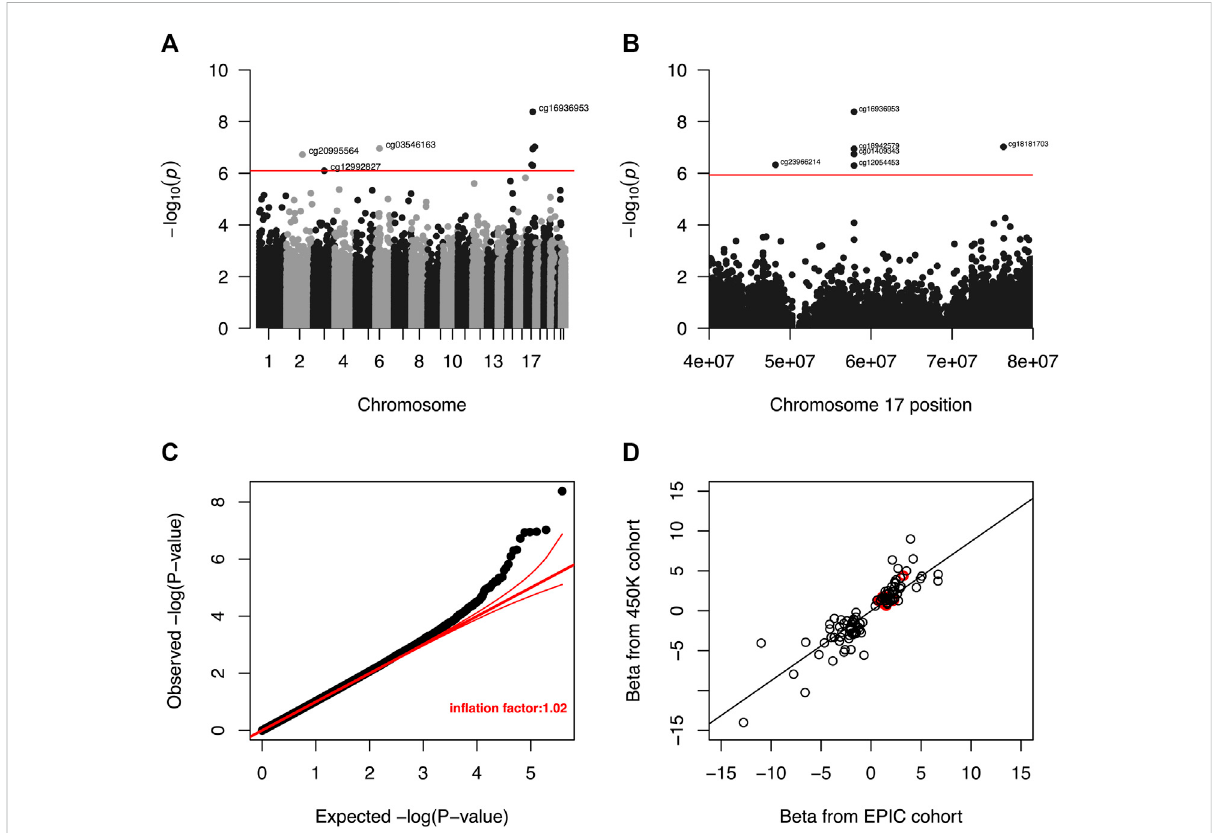
FIGURE 3 (A) Manhattanplotofunadjusted p -valuesfrommeta-analysisofEWASresultsforserum albumin.The redlineindicatestheunadjusted p -value thatcorrespondstoathresholdforFDR signi fi canceatQ < 0.05. DNAmethylationwasnotsigni fi cantly associatedwithserum albuminatanyDNAm site after a more restrictive Bonferroni correction to an overall a = 0.05. (B) Regional Manhattan plot of unadjusted p -values from meta-analysis of EWASresultsforCpGsitesinchromosome17andserumalbumin.Theredlineindicatestheunadjusted p -valuethatcorrespondstoathreshold for FDR signi fi cance (among all CpG sites from across entire genome) at Q < 0.05. DNA methylation was not signi fi cantly associated with serum for any CpG site after a more restrictive Bonferroni correction to an overall a = 0.05. (C) Quantile-quantile plot of unadjusted p -values from meta- analysis of EWAS results for serum albumin. The global in fl ation factor was 1.02. Red lines represent a distribution of null associations with a 95% con fi dence interval. (D) Correlation of beta coef fi cients obtained from separate EWAS of serum albumin among the EPIC and 450K cohorts for the 100 DNAm sites with the smallestunadjusted p -values after meta-analysis. Betacoef fi cients from the separate analyses are positively correlated (r = 0.89, p -value < 0.001), indicating that the signs of observed beta coef fi cient are consistent between the two datasets. Circles representing p -value pairs that were signi fi cant after meta-analysis and FDR correction to Q < 0.05 are highlighted in